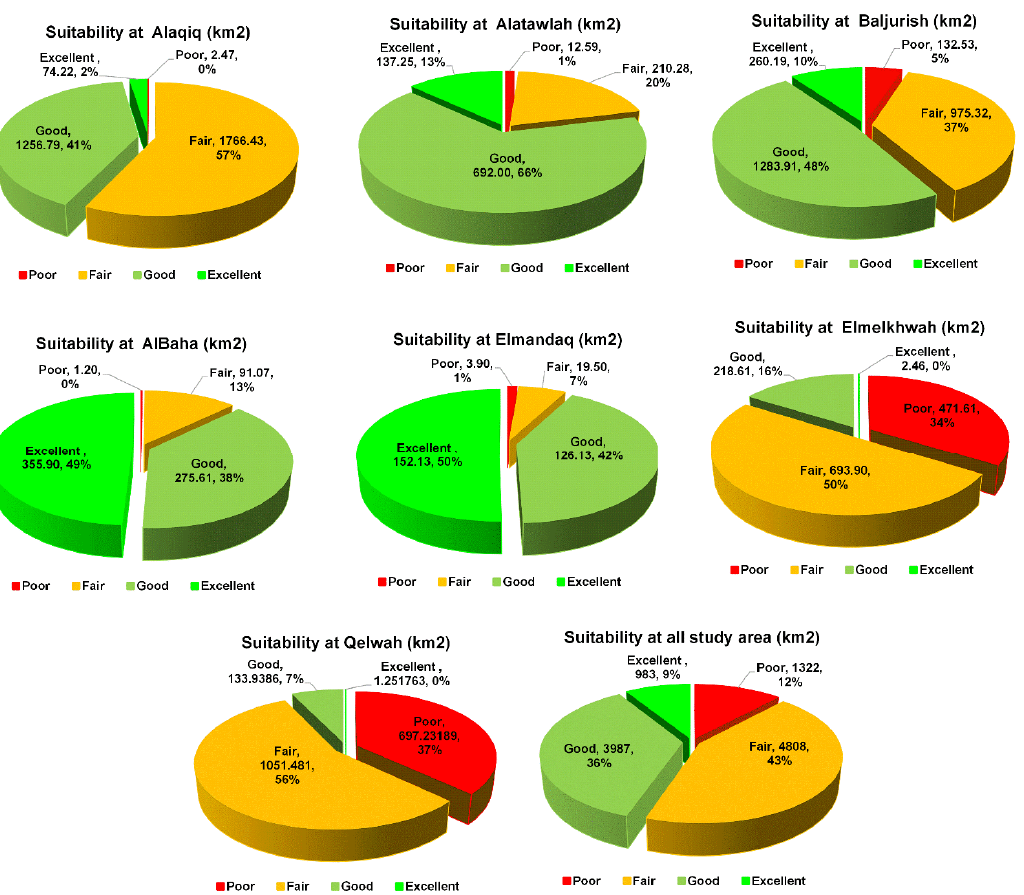
Figure 7. Area (km 2 ) and percentage (%) of the different classes of GI suitable areas in the Al Baha region and its seven districts.